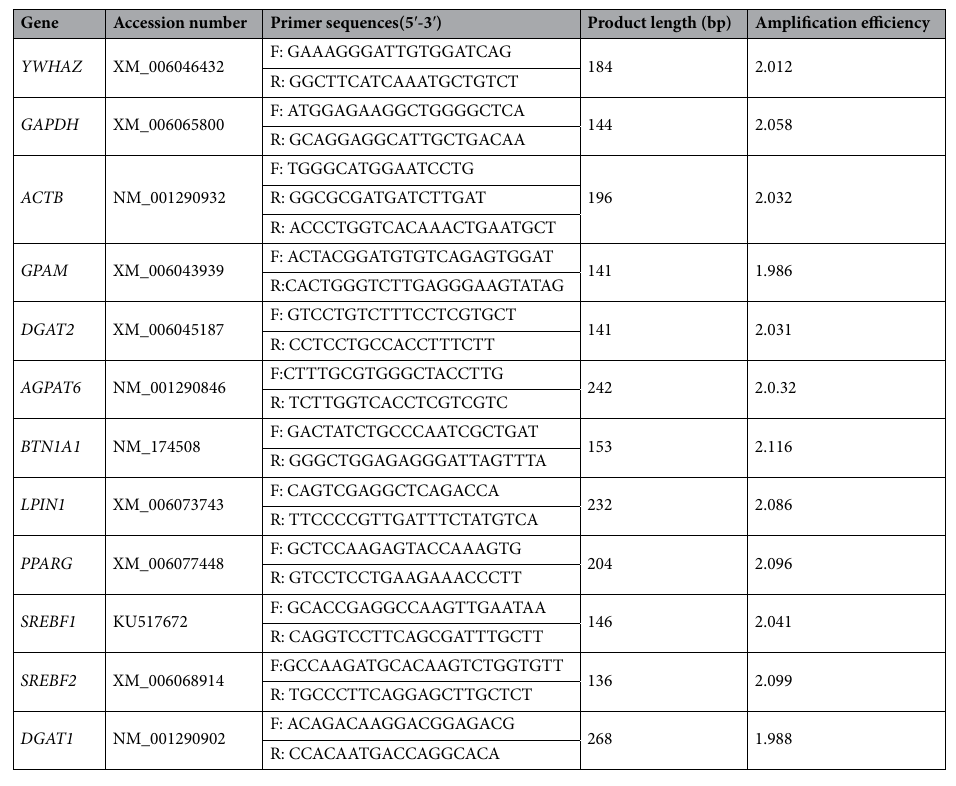
Table 2. The information of RT-qPCR primer sets used in this